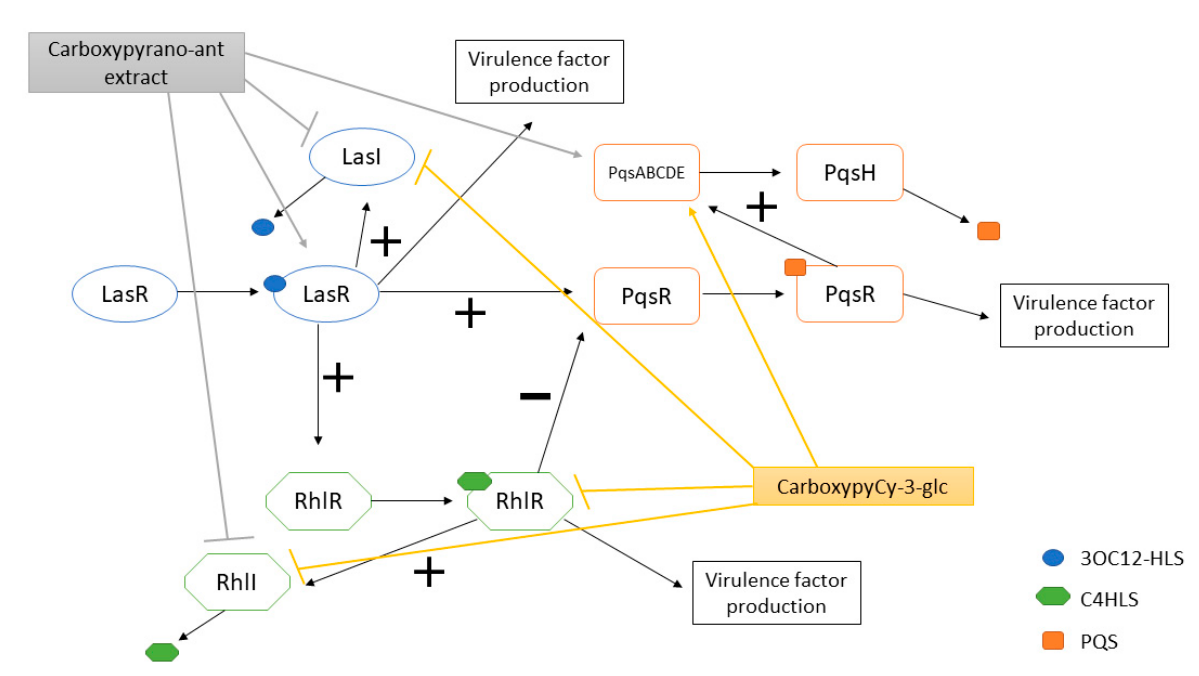
Figure 6. LasI/LasR, RhlI/RhlR and Pqs systems of P. aeruginosa and overview of the effects of carboxypyrano-ant extract and carboxypyCy-3-glc on the QS systems of P. aeruginosa ATCC 27853 and/or Pa3. (+): activation; ( − ): inhibition. The effects of the carboxypyrano-ant extract in the expression of S. aureus QS-related genes are shown in Figure 7A.